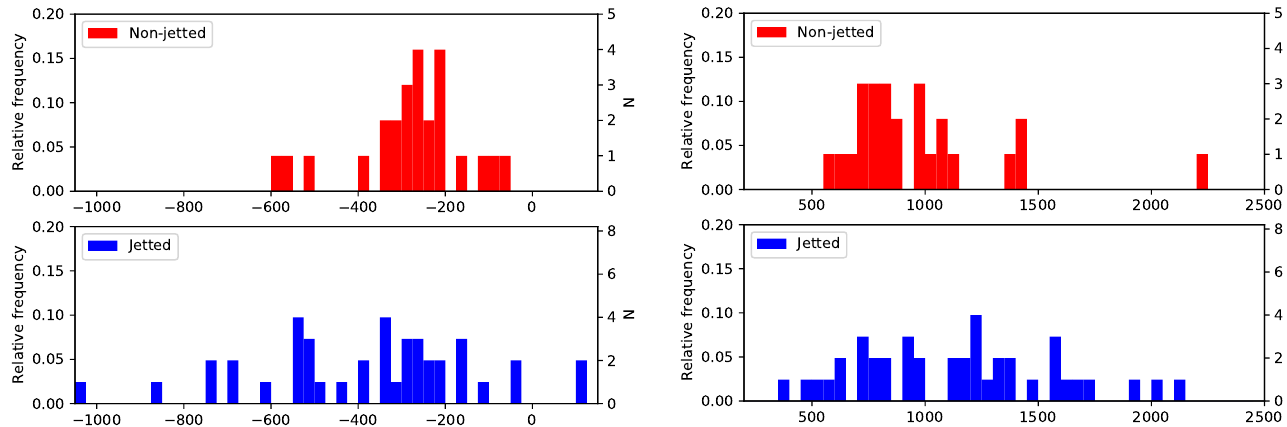
Figure 5. Left: distributions of the [O III] wing velocity shift in km s − 1 , in non-jetted (top panel) and jetted sources (bottom panel). Binning of 25 km s − 1 . Right: distributions of the FWHM([O III]) wing component in km s − 1 , in non-jetted (top panel) and jetted sources (bottom panel). Binning of 50 km s − 1